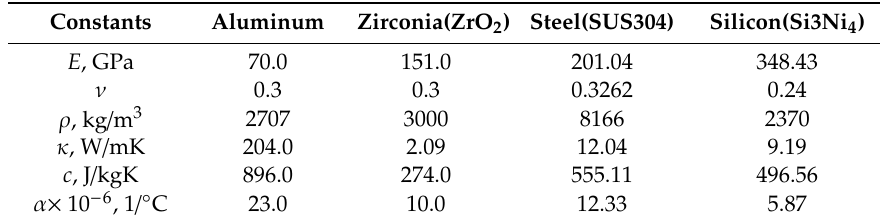
Table 1. Material properties of FGM